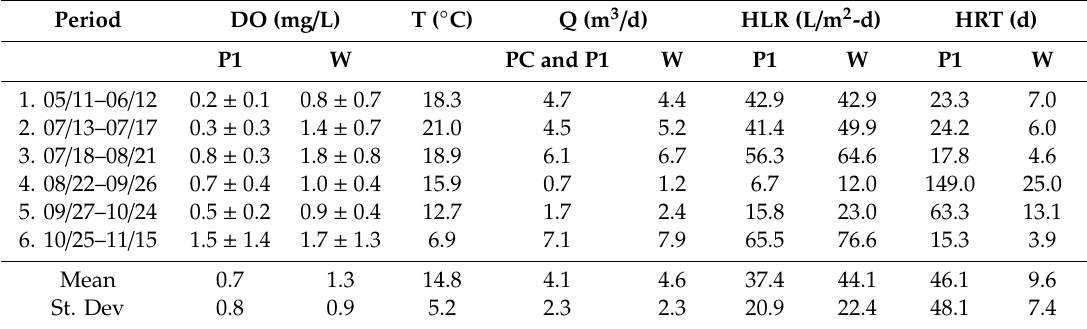
Table 1. Means of dissolved oxygen (DO) concentration, water temperature (T), flow (Q), hydraulic loading rate (HLR), and hydraulic retention time (HRT) for the six monitoring periods in the pond free water surface constructed wetland (FWS CW) system (Pump chamber, PC; primary treatment pond, P1; free-water surface constructed wetland,